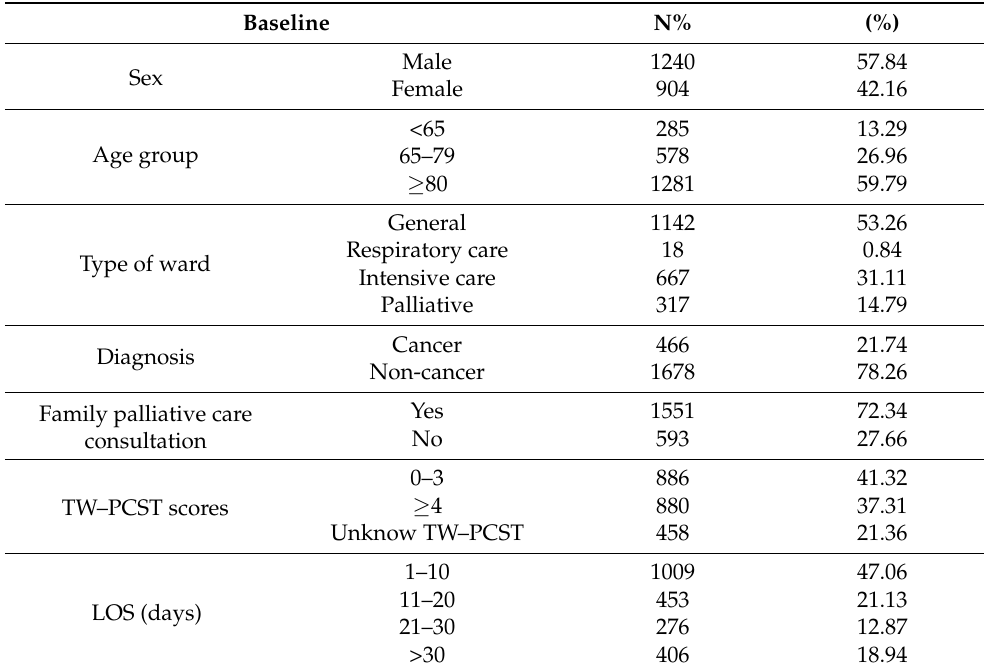
Table 1. Demographics of deceased patients at Taipei City Hospital from 1 January 2018, to 31